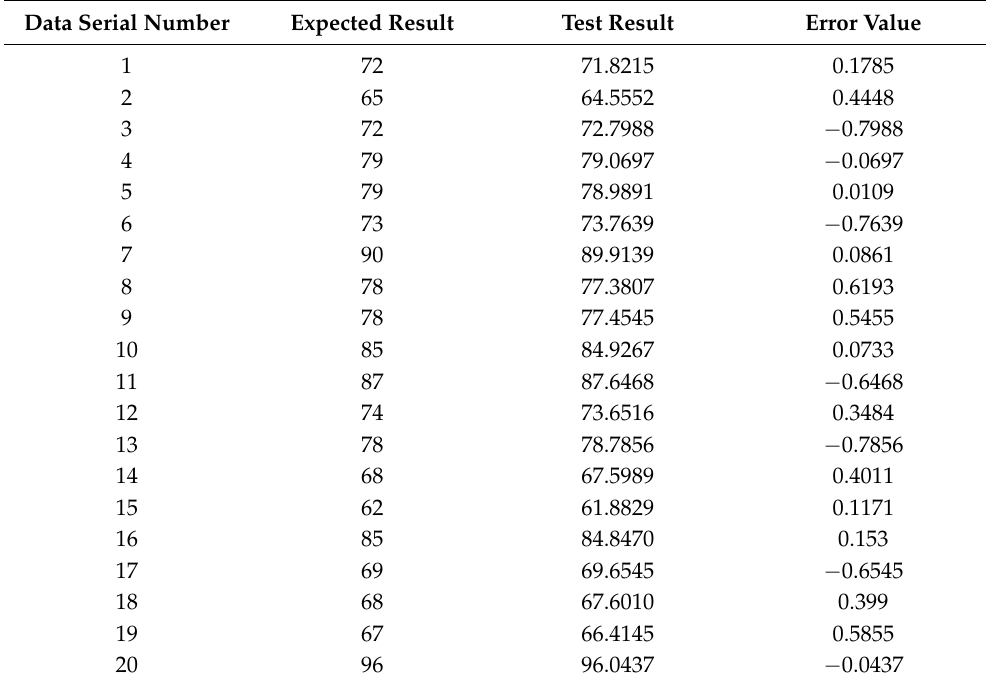
Table 3. Error table of test result data and expected result data.